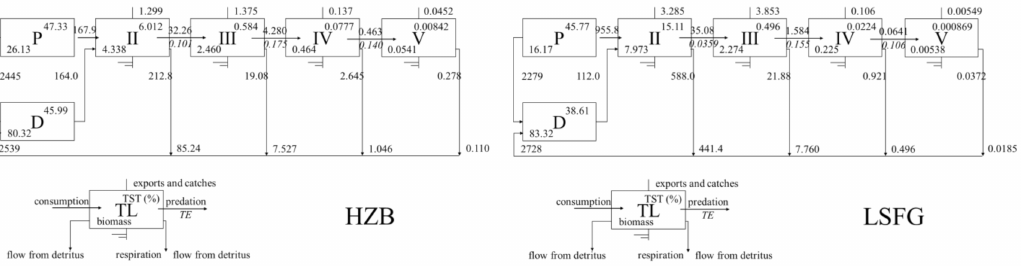
Figure 3. Trophic transfer efficiency ( TTE ) for the HZB and LSFG ecosystems. P = primary producer (phytoplankton), D = detritus, TL = trophic